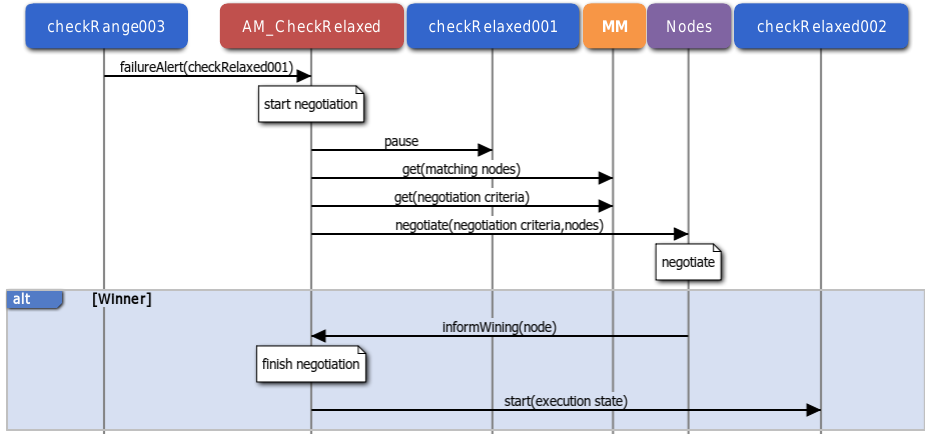
Figure 11. Application unaware availability: failure detection and stateful recovery.